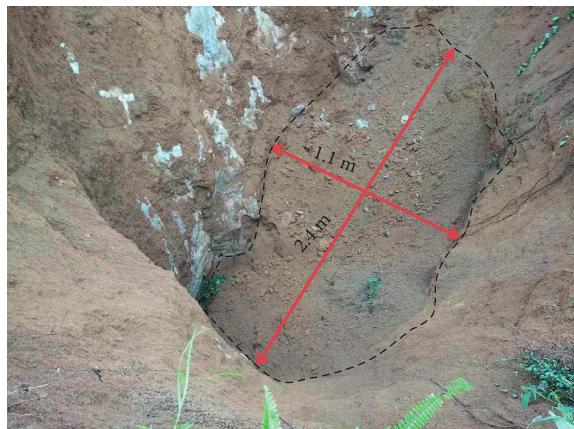
Figure 4: Surface subsidence around the Hebai tunnel.